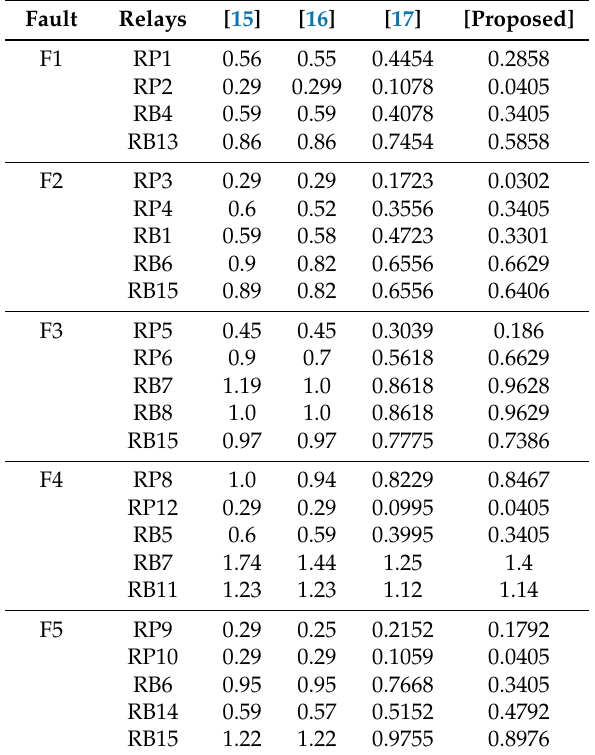
Table 7. Operation times for